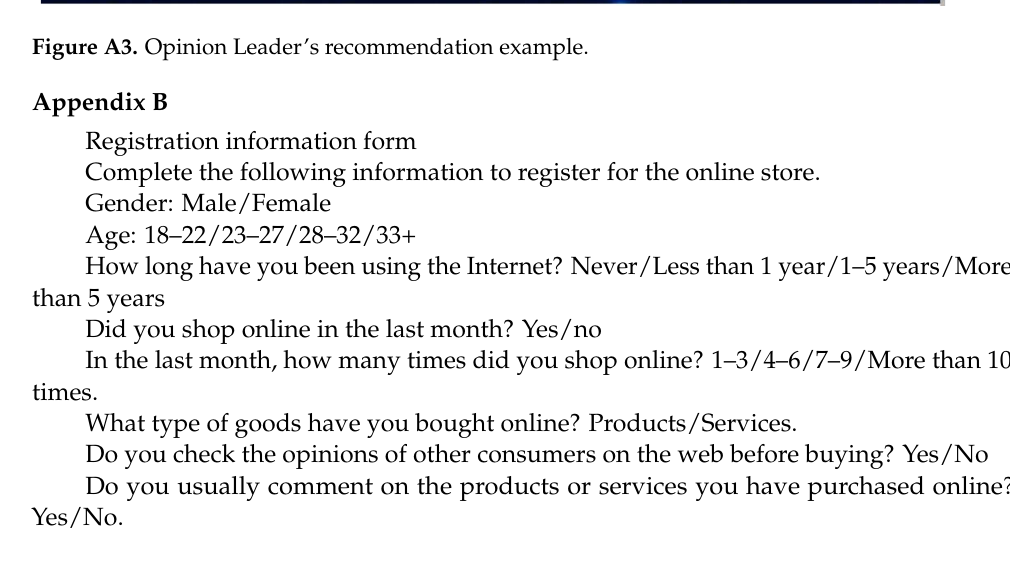
18 Appendix A Figure A1. Experimental stimulus: Services brands.